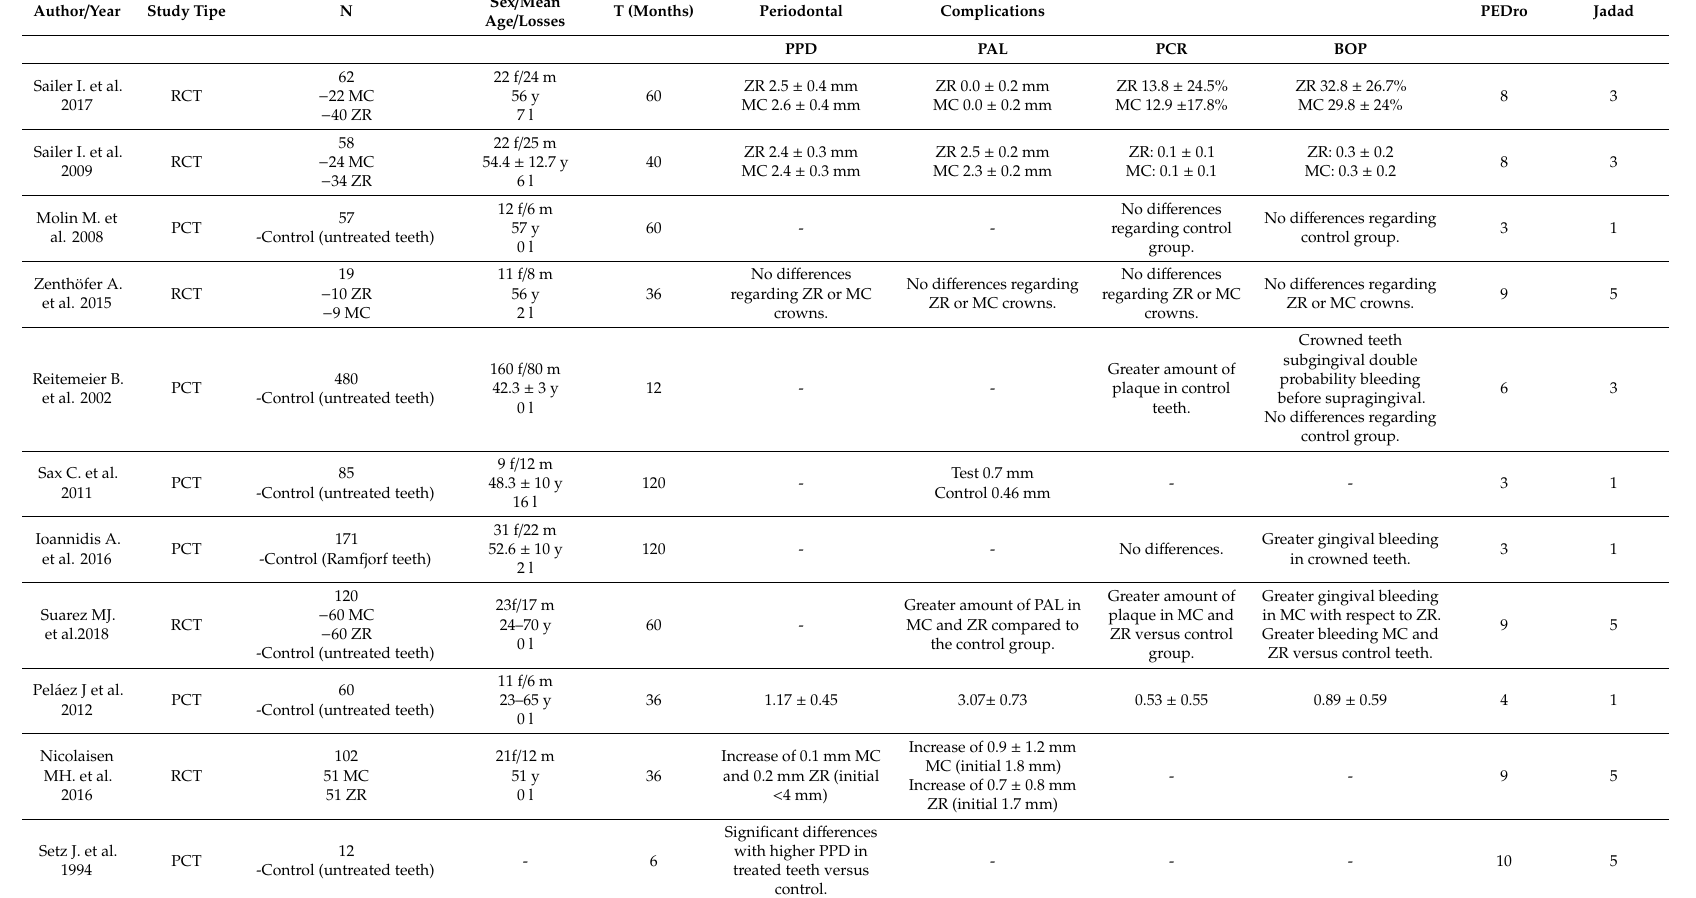
Table 3. Quantitative analysis of articles included in the systematic